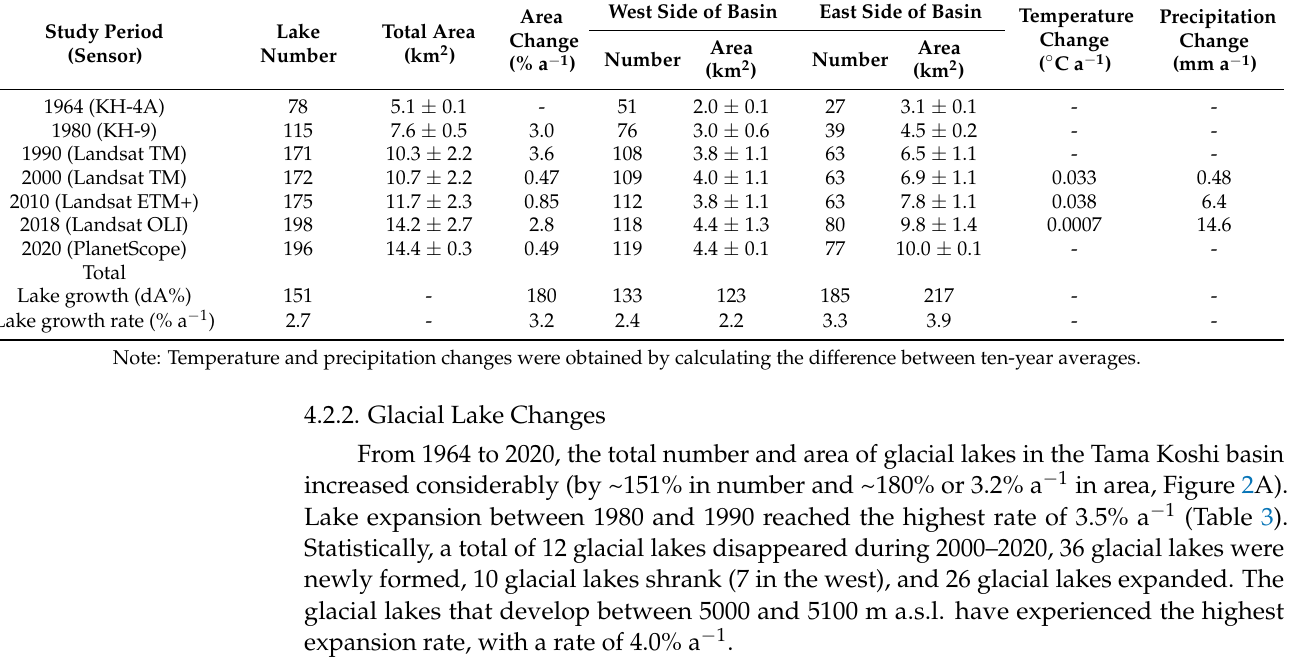
Table 3. Glacial lake inventories between 1964 and 2020 and changes in meteorological conditions in the Tama Koshi basin. Study Period Lake (Sensor) Number 1964 (KH-4A)